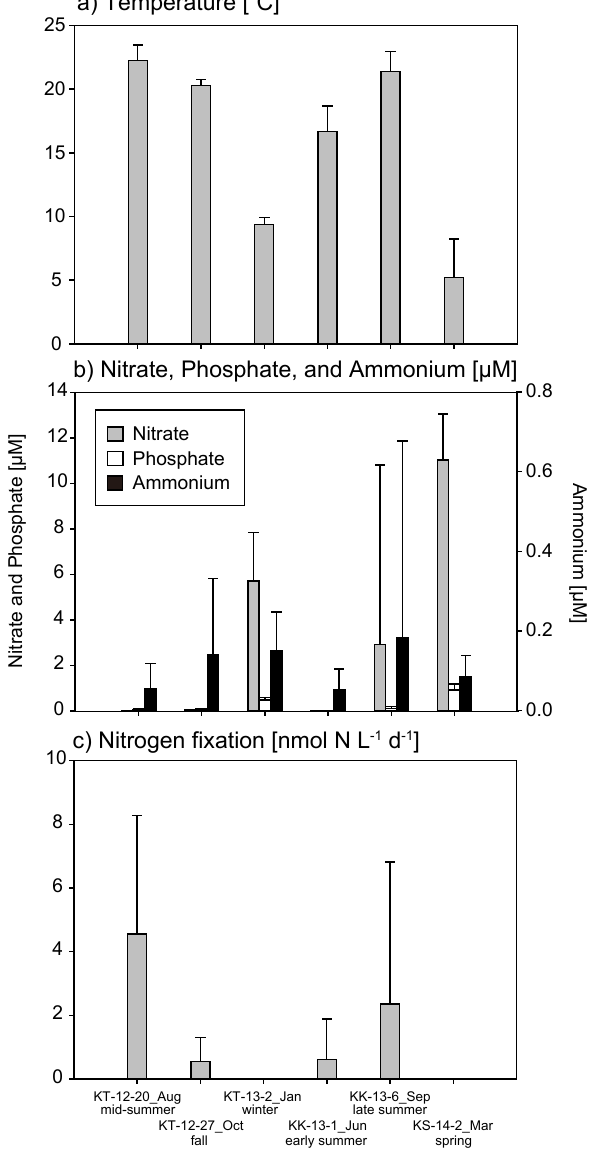
Figure 4. Average (a) temperature [ ◦ C], (b) nitrate, phosphate, and ammonium concentrations [µM], and (c) nitrogen fixation [nmolNL − 1 d − 1 ] at the surface during each